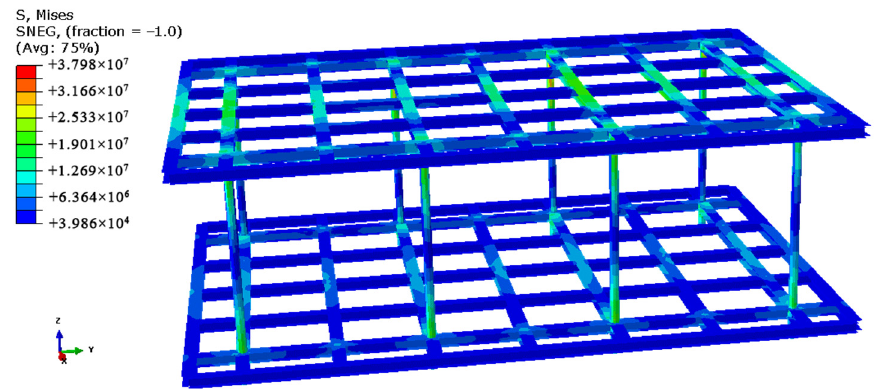
Figure 19. Model in ABAQUS .